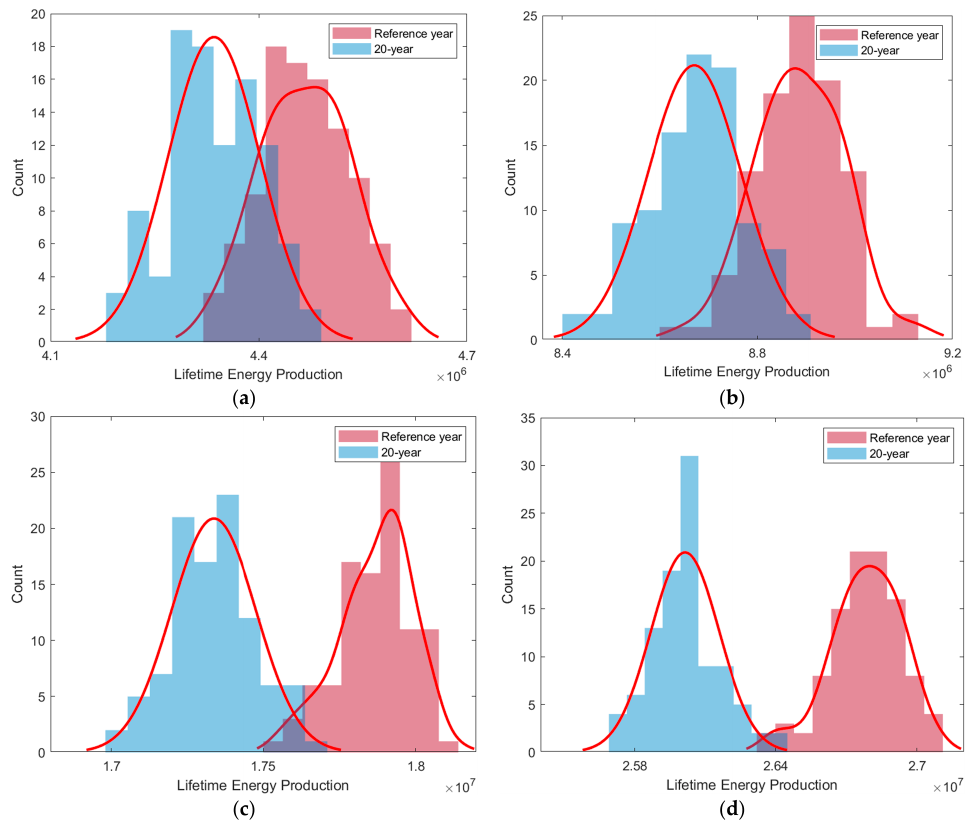
Figure 7. The lifetime energy production distributions resulted from the representative met-ocean reference year and twenty-year met-ocean data for ( a ) 5 turbines, ( b ) 10 turbines, ( c ) 20 turbines, ( d ) 30 turbines.